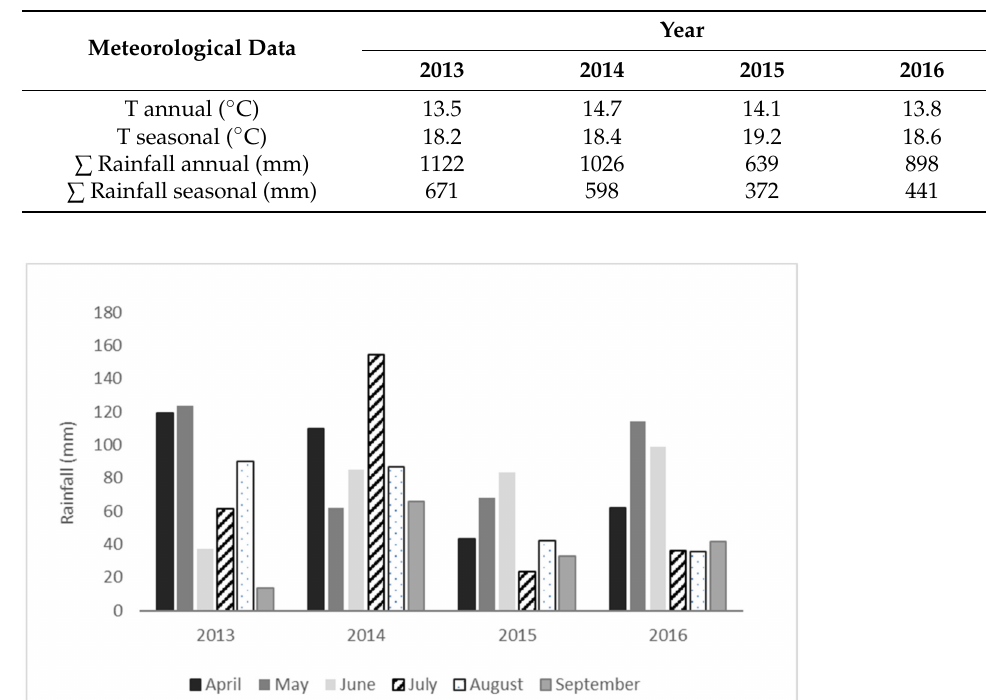
Table 1. Annual and seasonal mean temperatures and rainfall in the four study-years. Seasonal values are from 1st March to 30th September.